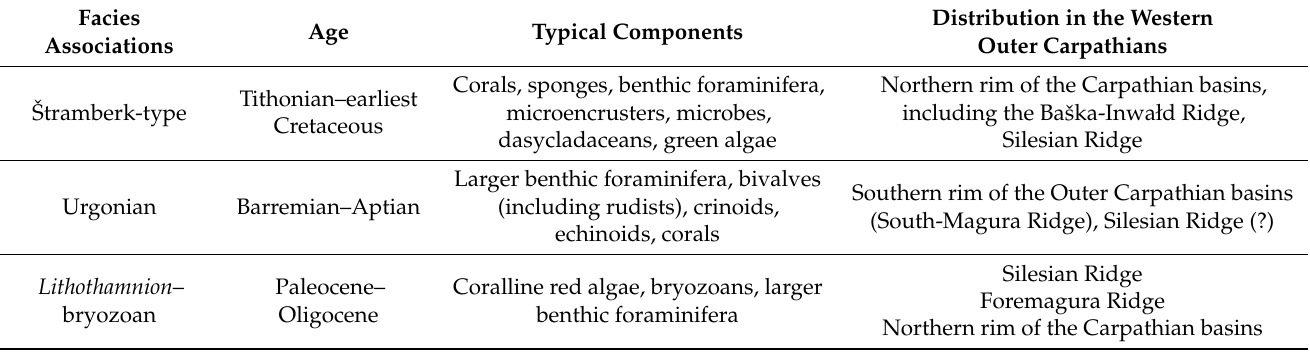
Table 1. Comparison of the existing types of facies